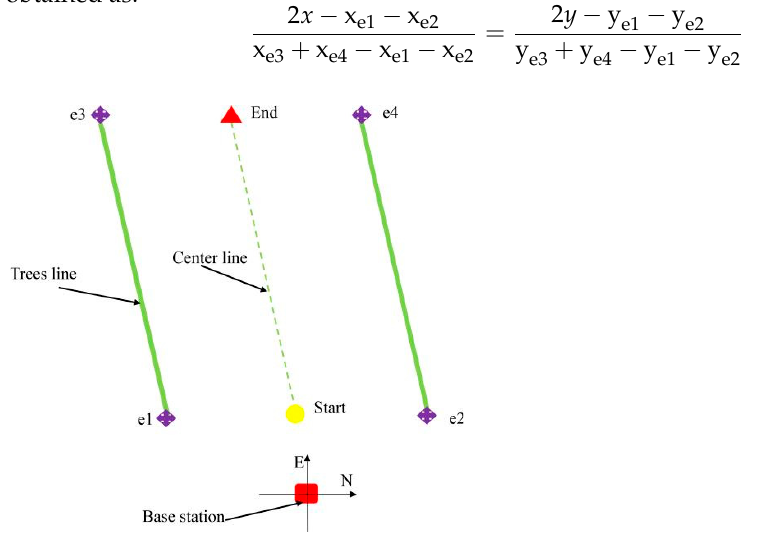
Figure 12. Determining the center line under the navigation coordinate system (NCS).